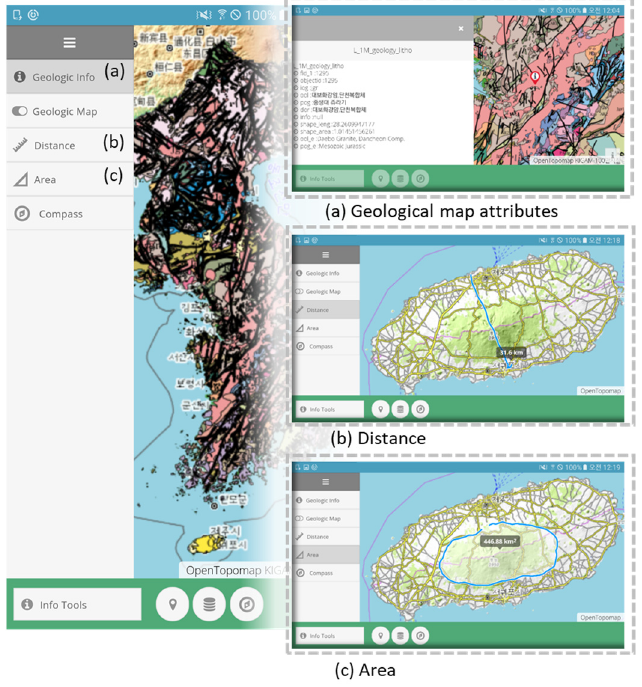
Figure 6. Info tool: ( a ) geological map attributes, ( b ) distance measurement, and ( c ) area determination.